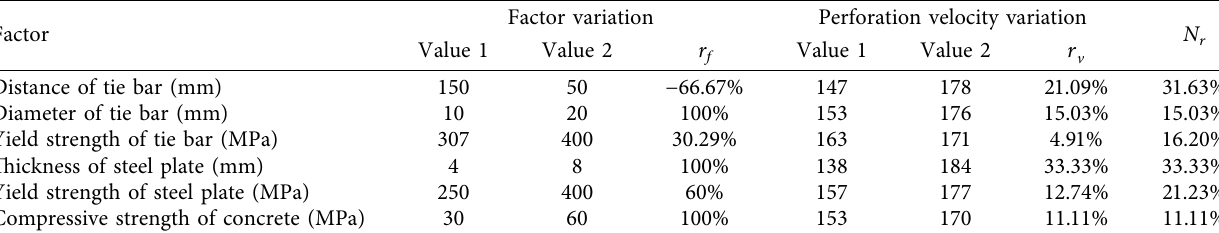
Table 11: Effect comparison of different factors on perforation velocity.